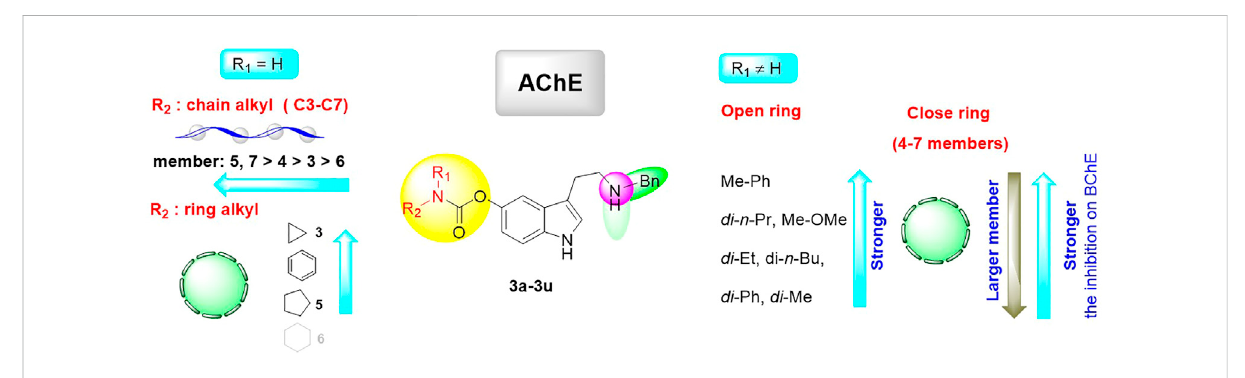
FIGURE 4 Outline of SARs of compounds 3a-3u on